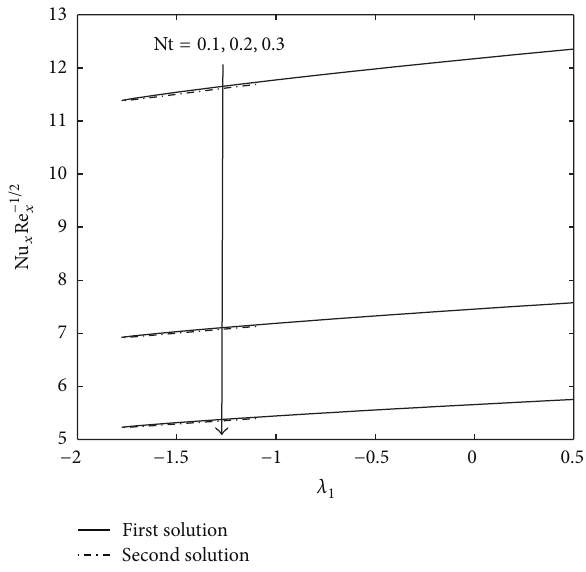
Figure 4: Variation of the local Nusselt number with 𝜆 1 for different values of Nt when 𝜆 2 = 1 , Pr = 6.8, Nb = 0.1, and Le = 5.